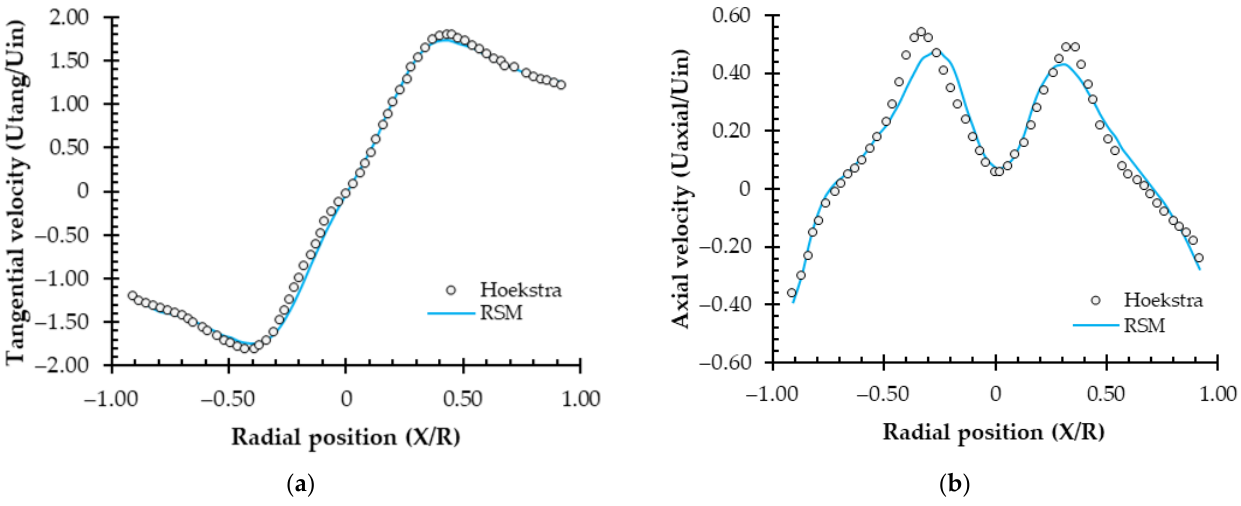
Figure 3. Comparison of velocity profiles between numerical simulation and results of Hoekstra; ( a ) Tangential velocity profiles, ( b ) Axial velocity profiles.